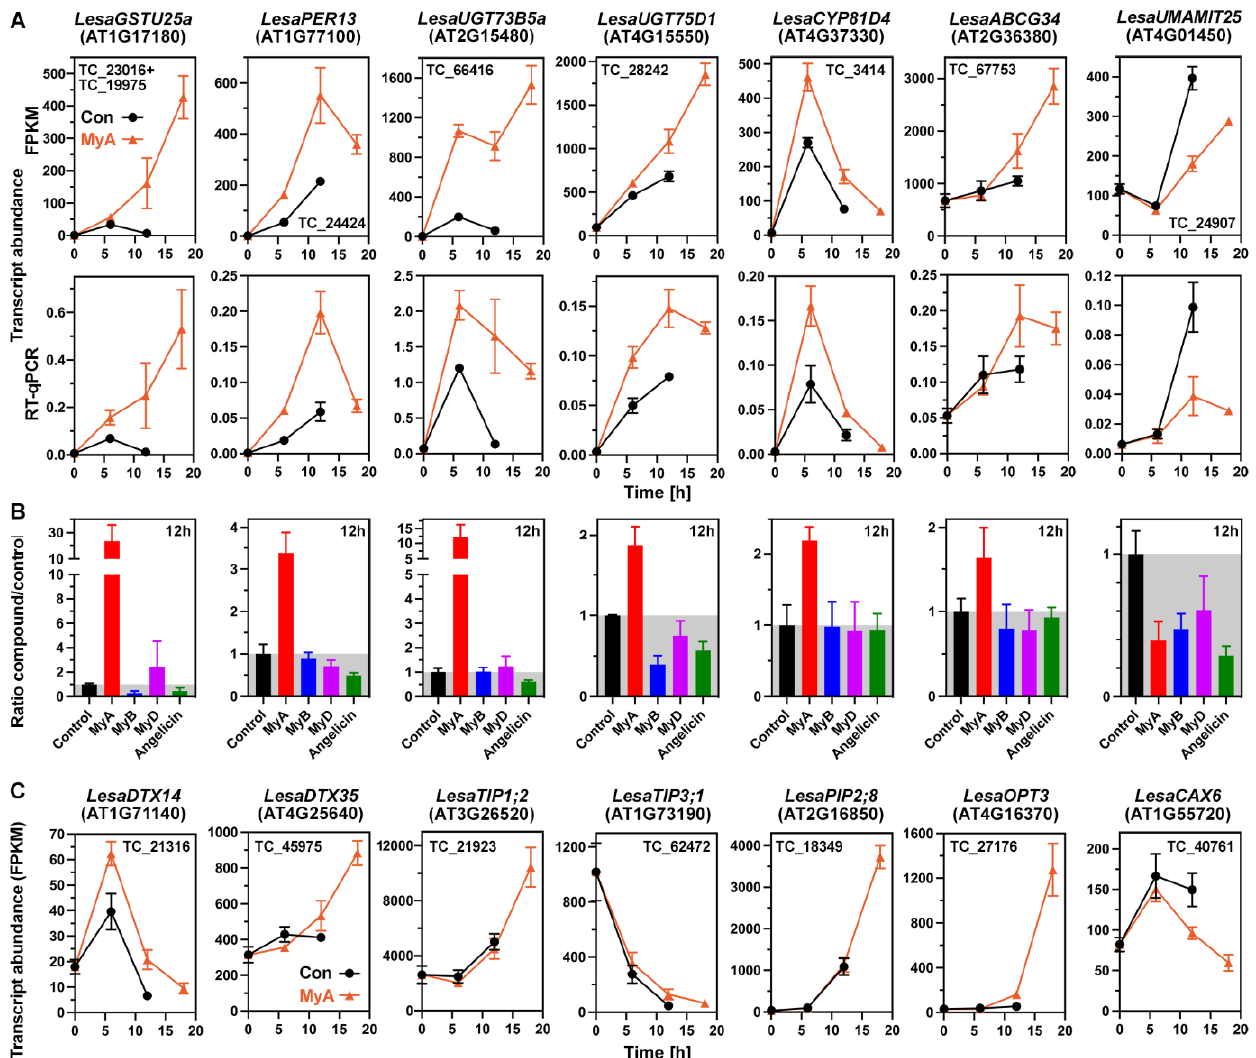
Figure 5. The effect of myrigalone A (MyA) and other compounds on the expression patterns of detoxification and transporter genes during Lepidium sativum (cress) seed germination. ( A ) Expression patterns of detoxification genes as affected by the MyA treatment of germinating seeds. ( B ) Relative transcript abundance ratios (compound/control) at 12 h during cress seed germination obtained by RT-qPCR analysis. ( C ) Expression patterns of transporter genes as affected by the MyA treatment of germinating seeds. The names of L. sativum ( Lesa ) genes are associated with the corresponding A. thaliana orthologs (AGI in brackets); see abbreviations for full names of genes. Transcript abundances are presented as mean ± SEM values (relevant transcript contigs (TC-IDs) included in each graph) based on 4–5 (FPKM) and 3 (qRT-PCR) biological replicates.